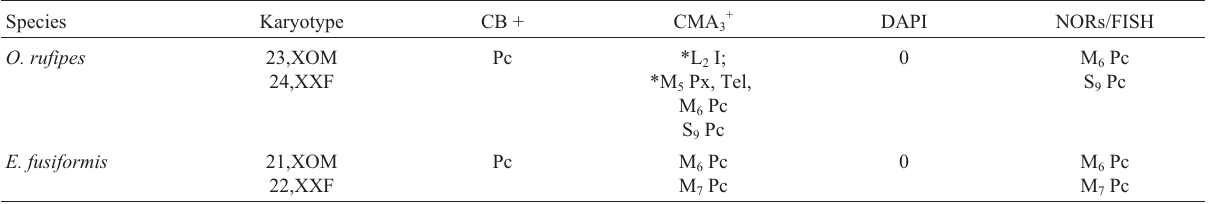
Table1 -Chromosomaldatafor Orthoscapheusrufipes and Eujivarusfusiformis ,showingthediploidnumberandsexdeterminationsystem,thedistribu- tion and classification of CH based on C-banding and staining with base-specific fluorochromes, and the occurrence of NORs detected by AgNO 3 and